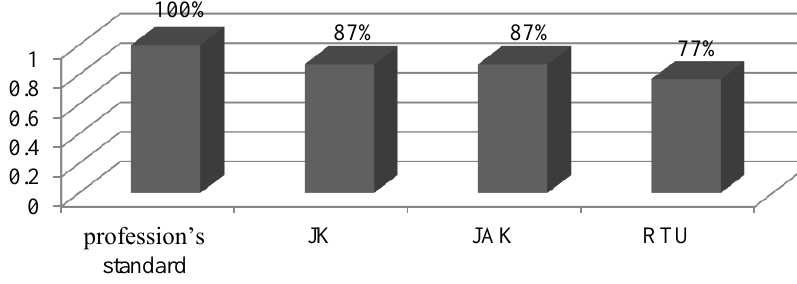
Fig. 2 . Compliance of the content of the study program to the profession’s standard (the author’s